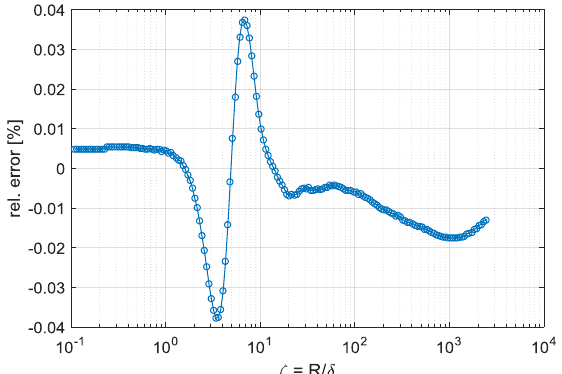
Figure 9: Semi logarithmic plot of the relative error of the approximated total inductance for 𝑙/𝑠 = 25 in function of the dimensionless frequency 𝜁